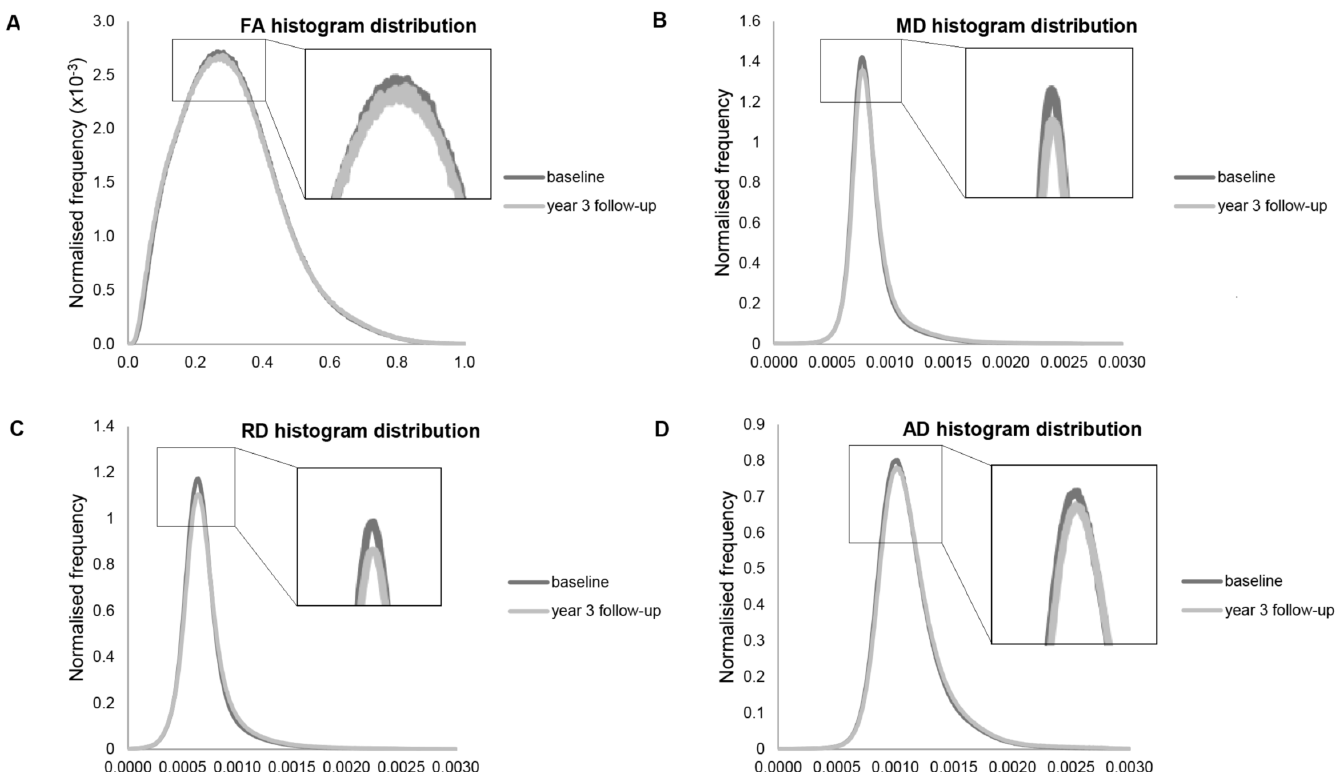
Fig 4. Average DTI histogram distributions of the baseline longitudinal cohort and at 3 year follow-up. A. Fractional anisotropy. B. Mean diffusivity (mm 2 s -1 ). C. Radial diffusivity (mm 2 s -1 ). D. Axial diffusivity (mm 2 s -1